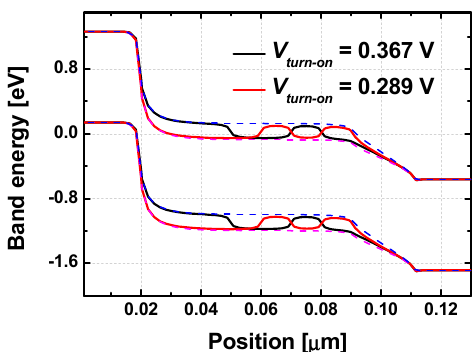
Figure 4. Energy band diagrams of planar TFETs with the highest value of V turn-on at 0.367 V (black solid line) and the lowest value of V turn-on at 0.289 V (red solid line) among the simulated samples when V D is 0.5 V and V G is 0.4 V. The blue dashed line and magenta dashed line show the most extreme cases in theory when the entire gate of the planar TFET is 4.6 and 4.4 eV, respectively.